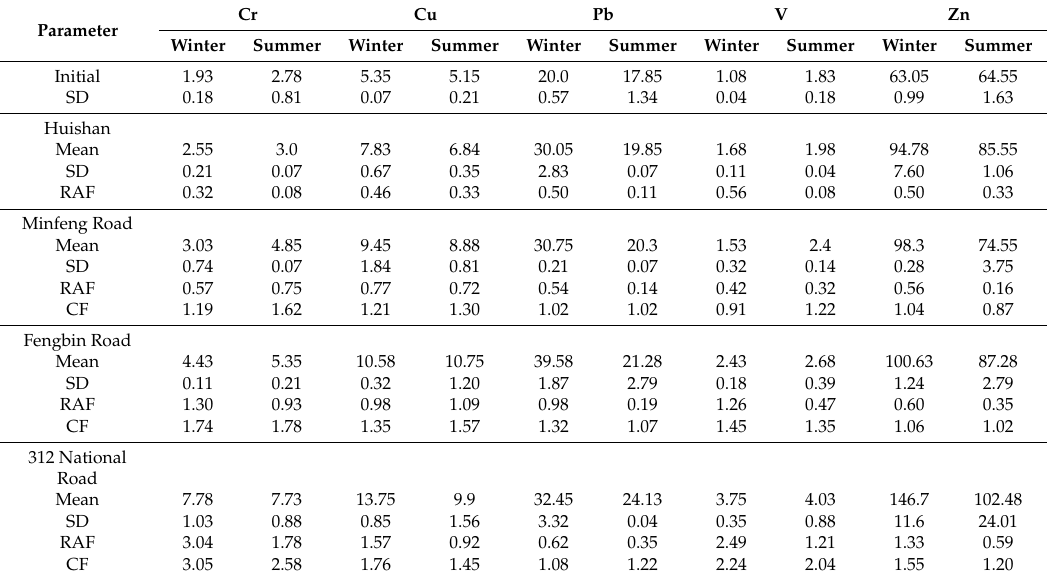
Table 1. The concentration of metals (mg · kg − 1 , dry weight) in the moss bags over 6 weeks during the winter and